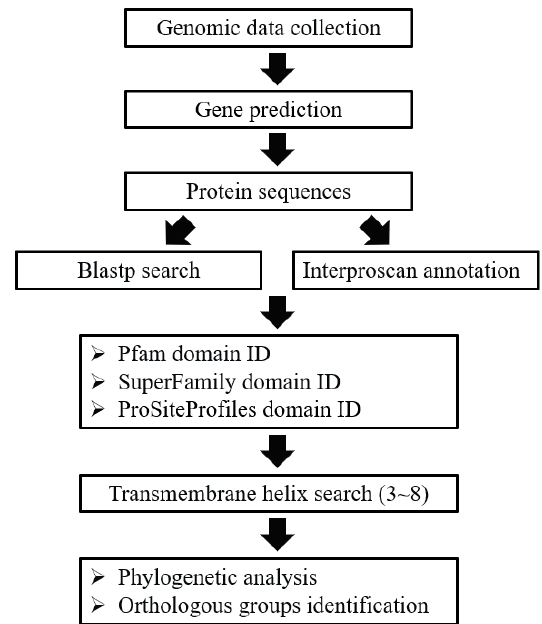
Figure 6. Pipeline used to identify GPCRs in